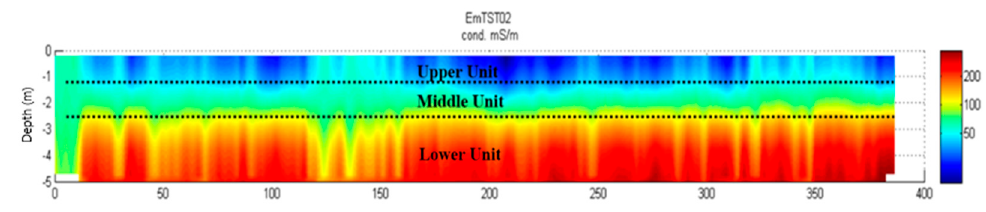
Figure 7. Representative conductivity results for the transect EmTST02 of the studied field with the three sedimentological units.